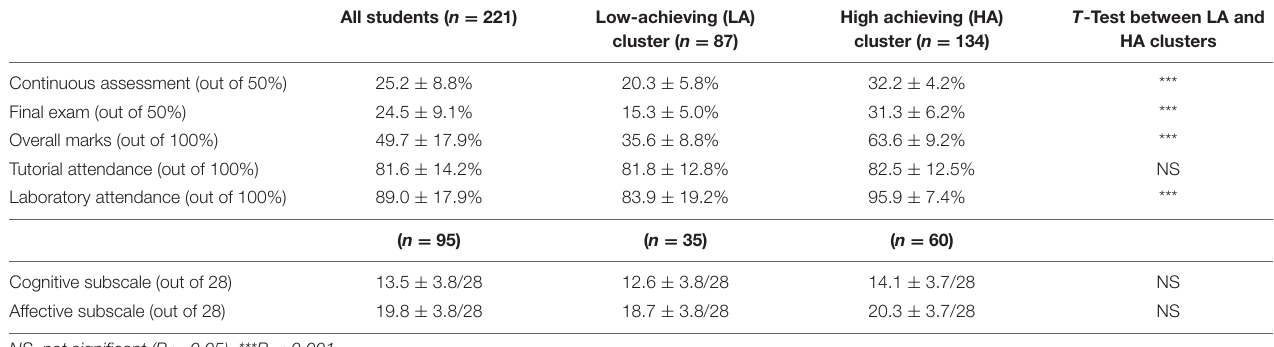
TABLE 2 | Mean scores for the assessment items, attendance scores, and ASCI subscales.